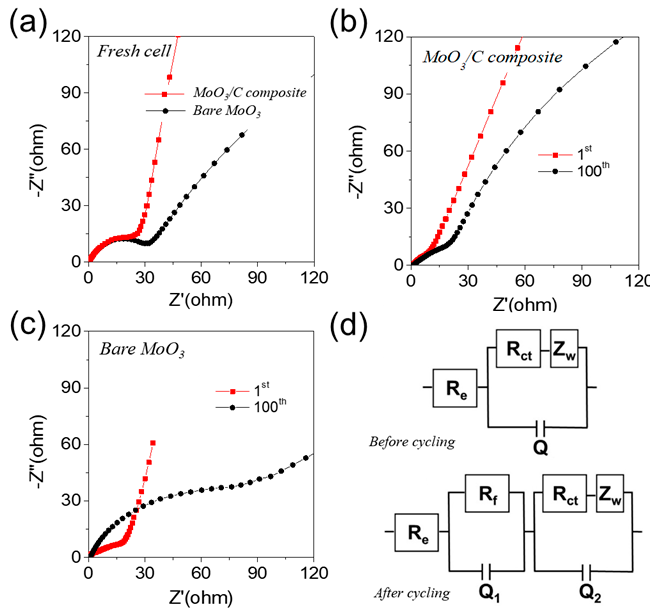
Figure 6. The impedance analysis of the MoO 3 /C composite microspheres and the bare MoO 3 powders: ( a ) before cycling, ( b ) bare MoO 3 powders, ( c ) MoO 3 /C composite microspheres, and ( d ) the tquivalent circuit model used for AC impedance fitting: R ct = charge-transfer resistance, R e = electrolyte resistance, R f = SEI layer resistance, Q 1 = dielectric relaxation capacitance, and Q 2 = associated double layer